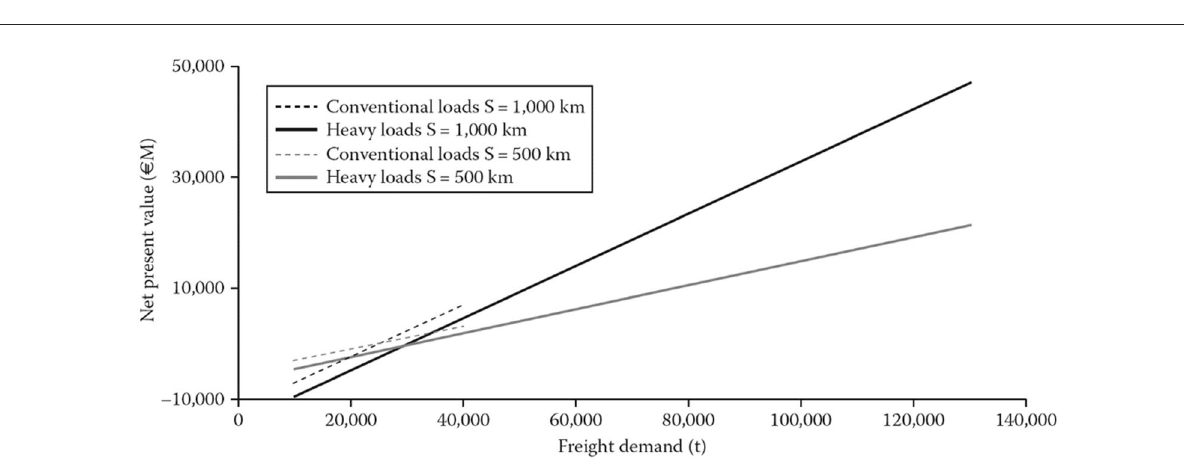
FIGURE4 NPV as a function of freight demand expressed in tonnage borne for a conventional axle-load and a heavy haul line – length of connection S = 500 to 1,000km (Pyrgidis and Christogiannis,